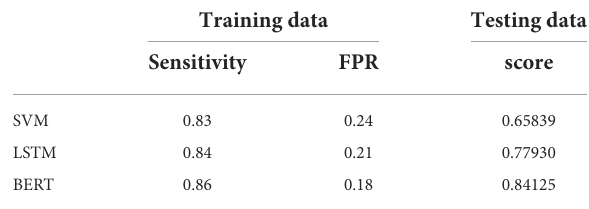
TABLE 4 The prediction performance of three classifiers (SVM, LSTM, and BERT).